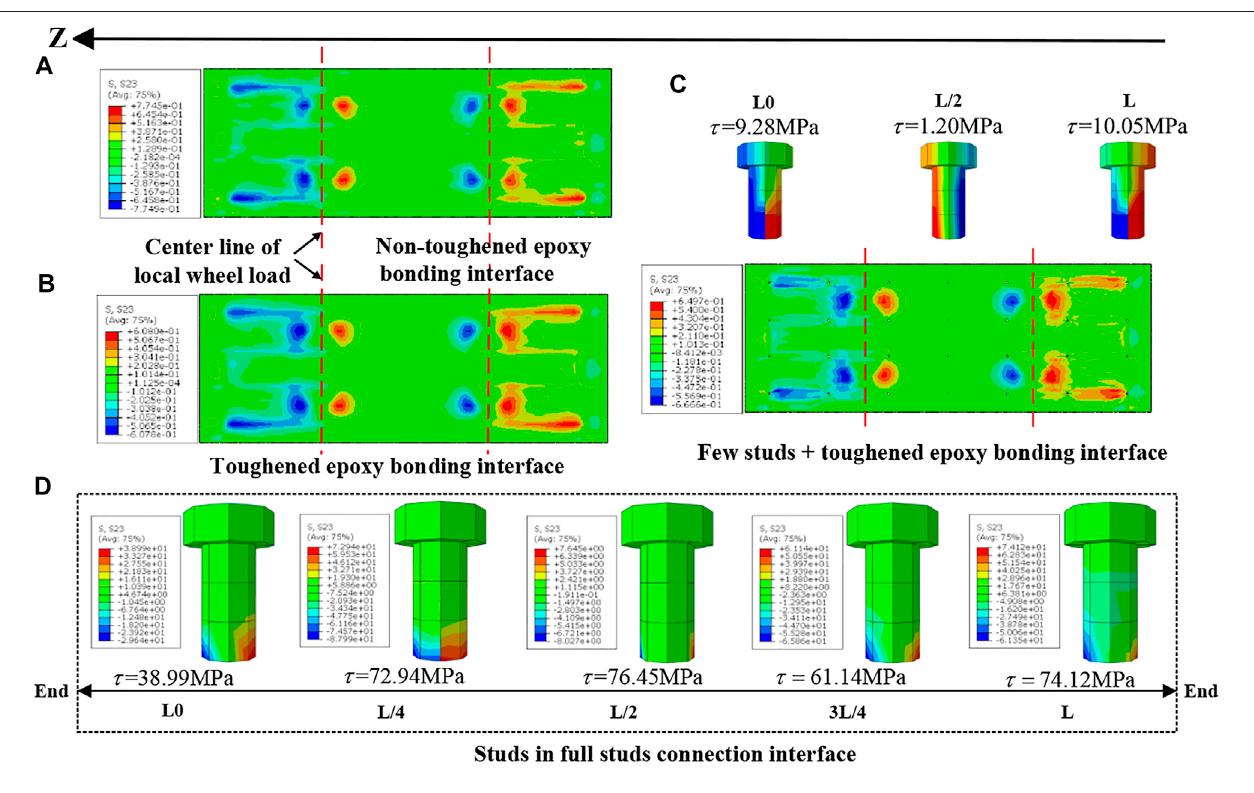
FIGURE 11 | Interface stress distribution under standard wheel load. (A) Non-toughened epoxy bonding interface. (B) Toughened epoxy bonding interface. (C) Few studs + toughened epoxy bonding interface. (D) Studs in the full stud connection interface.